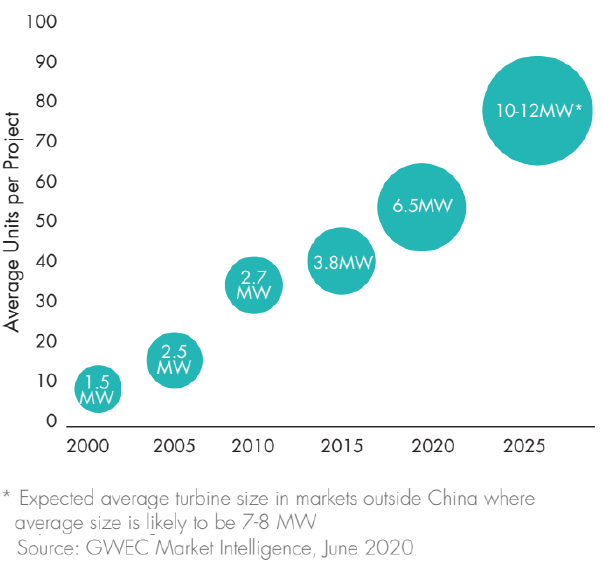
Figure 7. Evolution of offshore wind turbine size (Reprinted with permission from [45]. 2020, GWEC). Table 1. An example of a commercially available large wind